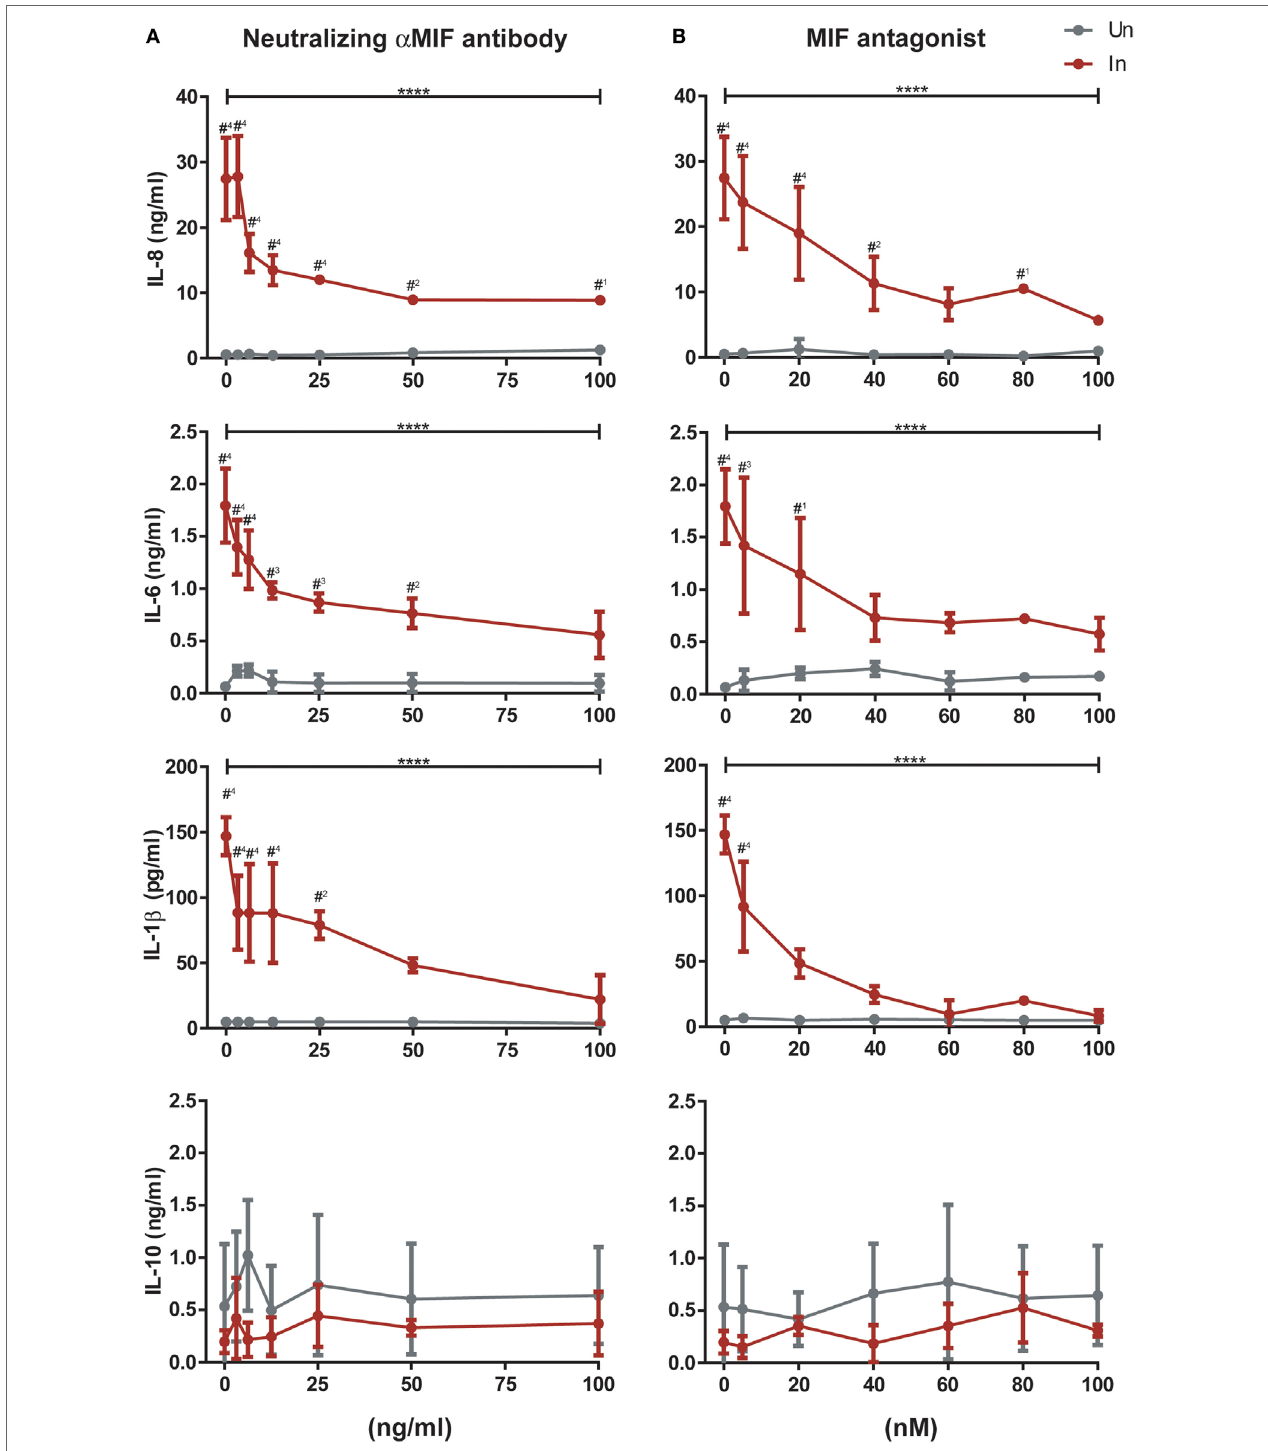
FigUre 5 | Effect of macrophage migration inhibitory factor (MIF) neutralization in the expression of cytokines from primary human immunodeficiency virus-infected and uninfected monocyte-derived macrophages (MDMs). Serial dilutions of a neutralizing α MIF antibody (clone NIHlllD.9) (a) , and the MIF antagonist MIF098 (B) were used to inhibit MIF activity in infected (In, red lines) and uninfected (Un, gray lines) MDMs at a constant concentration of this cytokine (25 ng/ml). Data represent three independent experiments (donors), each evaluated in duplicate. Data represent the mean ± SD. Data were analyzed by two-way ANOVA followed by Tukey’s post-test (intragroup analysis, In group only; **** p < 0.0001) or by Sidak’s post-test (intergroup, In versus Un; #1 p < 0.05, #2 p < 0.01, #3 p < 0.001, #4 p < 0.0001). Asterisks corresponding to the intragroup analysis are shown above the horizontal bars, and those from the intergroup analysis are shown above points corresponding to each antagonist or antibody